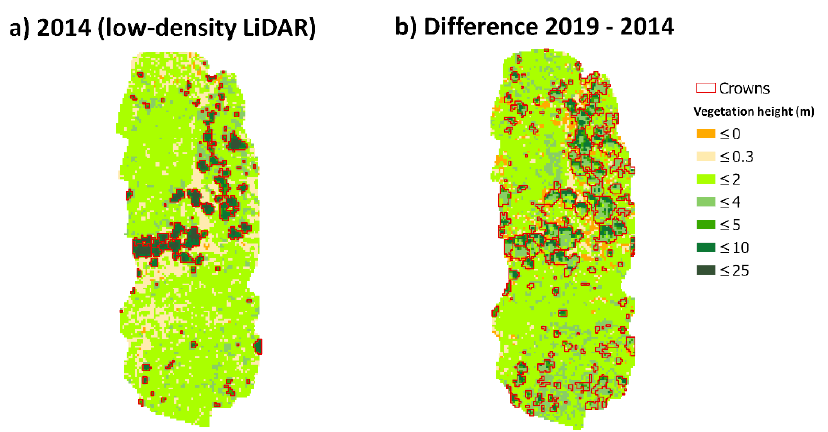
Figure 8. Canopy height models (CHMs) derived from ( a ) low-density LiDAR data (2014) and ( b ) the difference between low- and high-density LiDAR derived CHMs. In red, the crowns shapes identified in low-density LiDAR ( a ) and those from the high-density LiDAR dataset ( b ).